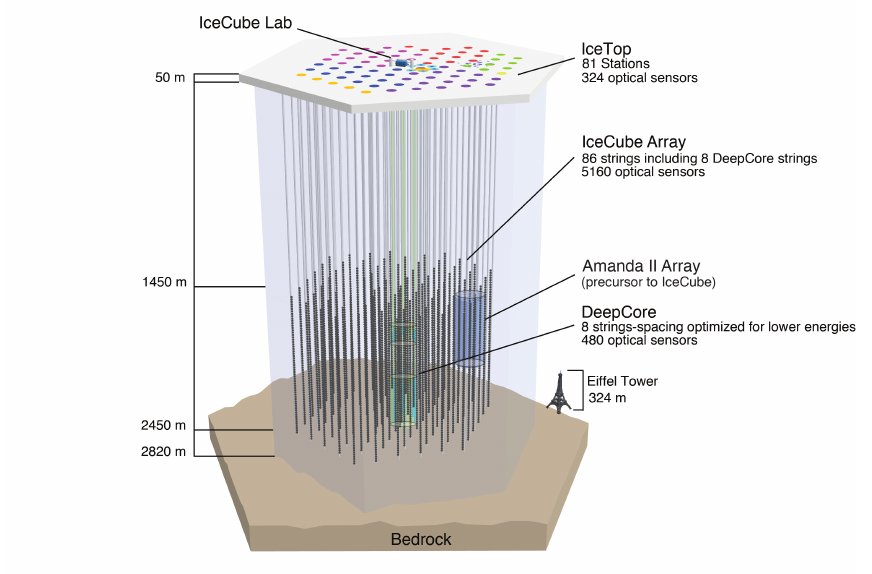
Figure 1: Schematic picture of the IceCube detector, showing the position of Amanda, IceCube’s predecessor, the dense infill array IceCube DeepCore and the IceTop surface detector for the detection of cosmic rays. All data is collected in the IceCube Lab on the ice